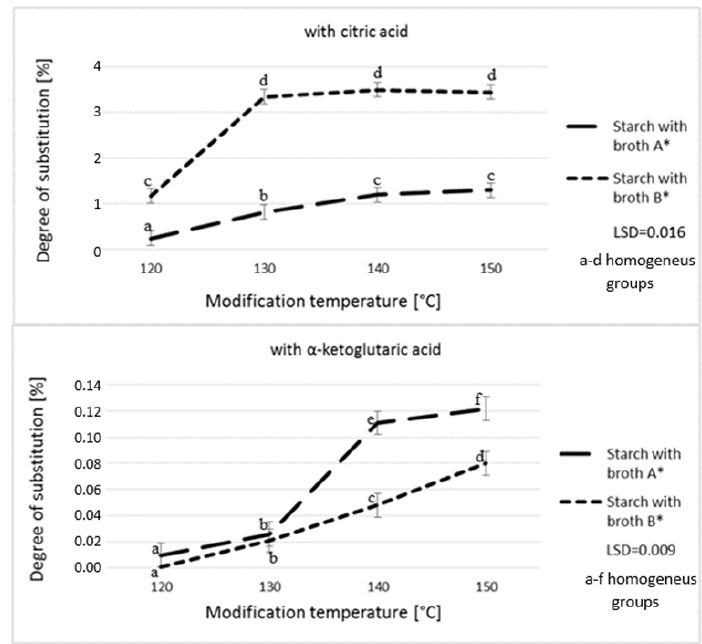
Figure 2. Effect of modification temperature on the degree of starch substitution. * Broth A— α -ketoglutaric acid 60 g/L; citric acid 18 g/L; pyruvic acid 1 g/L; Broth B— α -ketoglutaric acid 49 g/L; citric acid 46 g/L; pyruvic acid 1.5 g/L.